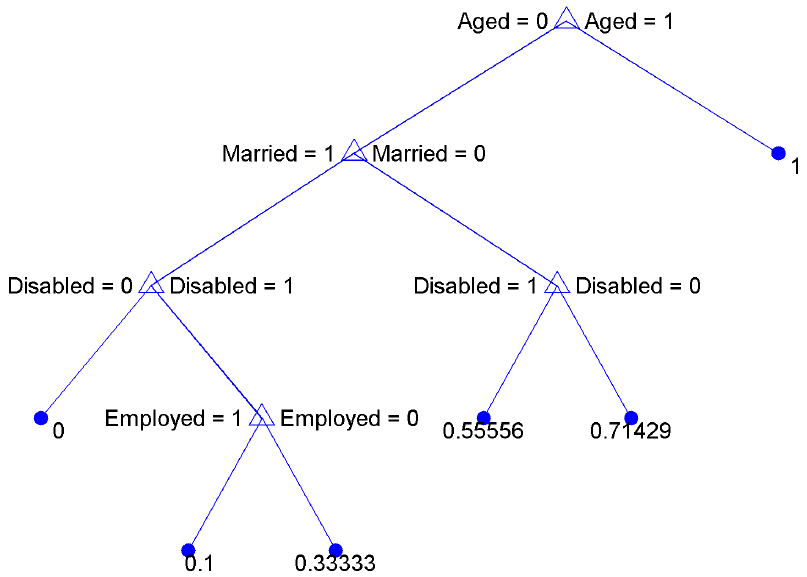
Figure 3. Decision tree for determining a genuine social safety net program (SSNP) beneficiary: here, “Aged = 0” means Age is below 65, “Aged = 1” means Age is 65 and above, “Married = 0” means widow / widower, “Married = 1” means married, “Employed = 0” means unemployed, “Employed = 1” means employed, and the end leaves show the probability of genuine beneficiary status.